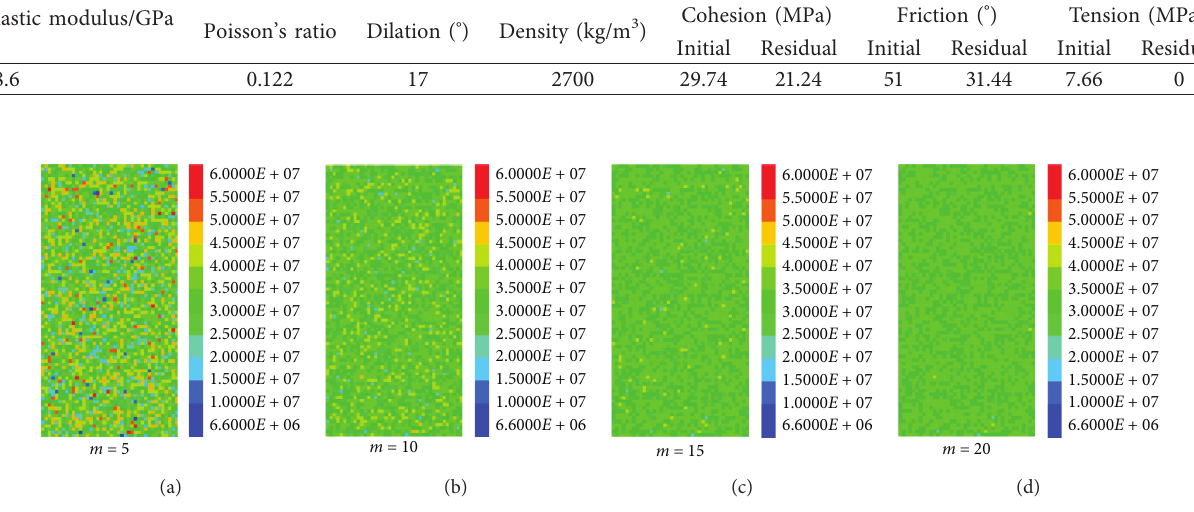
Figure 7: Cohesion distribution in models of Beishan granite with different homogeneity index m (a) m � 5. (b) m � 10. (c) m � 15. (d) m �